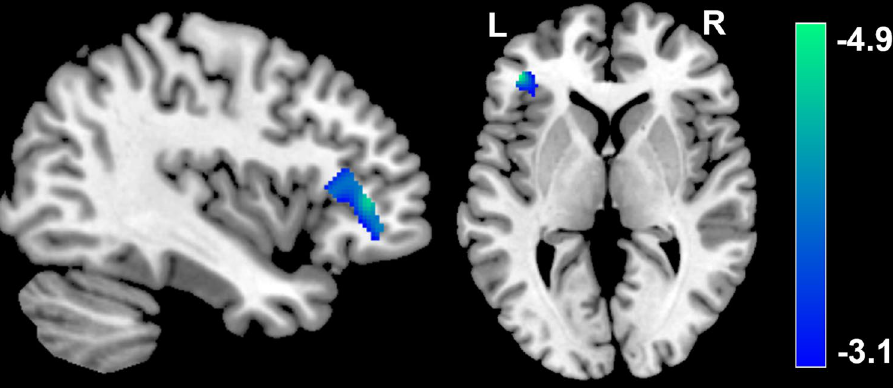
Figure 2. Association between TTF scores and WMV. The left IFG had a significant and negative correlation with TTF scores. Results are shown at p < 0.05, corrected for multiple comparisons at the cluster-level, with an underlying voxel level of P < 0.001, uncorrected. The color density represents the T score. TTF: tendency to forgive; WMV: white matter volume; IFG, inferior frontal gyrus; L, left; R,